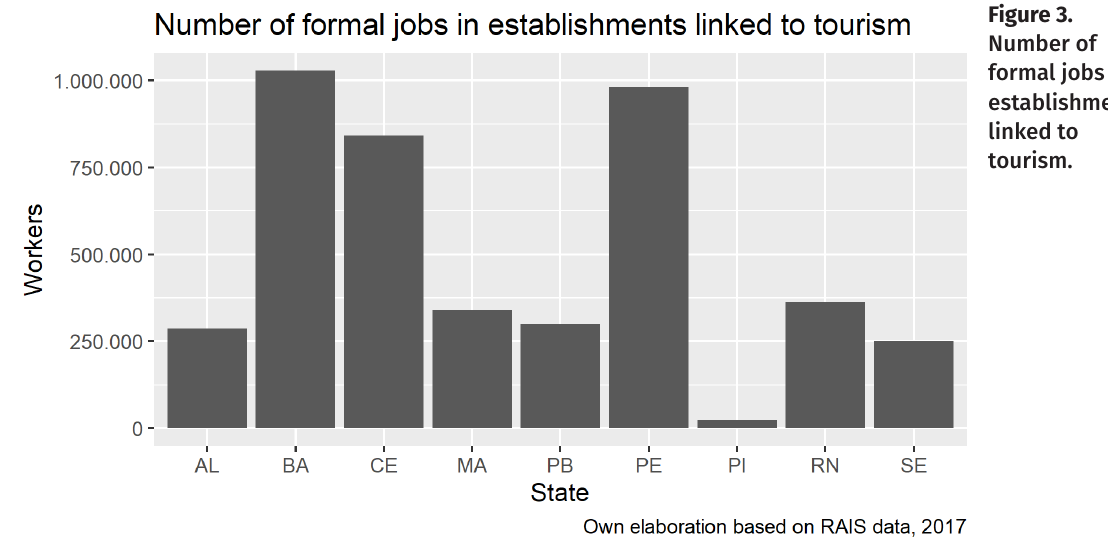
formal jobs in establishments linked to